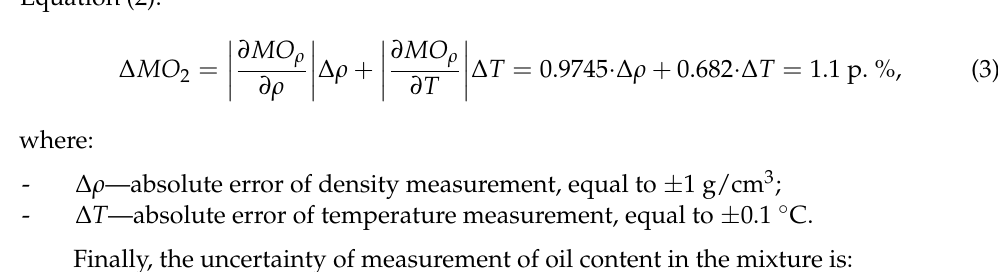
Figure 5. Differences between the real and calculated values of the mineral oil concentration in its mixture with the synthetic ester Δ MO ρ 1 ( a ) and the absolute values of the largest differences for all temperature values ⏐ Δ MO ρ 1 ⏐ ( b ).